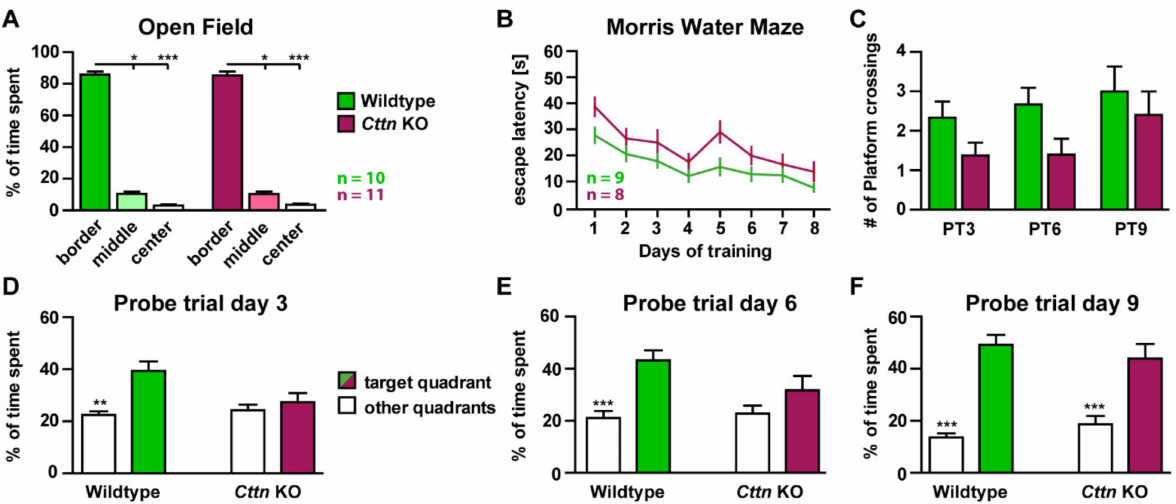
Figure 1. Behavioral analysis of Cortactin-deficient mice. ( A ) Wildtype and Cttn-deficient mice trained in the Open Field test [28]. Depicted is the percentage of time spent in the center, middle and border region of the test arena. n = number of animals. ( B ) Escape latency of male WT and Cttn-deficient animals trained for 8 days in the hidden platform version of the Morris Water Maze [29]. n = number of animals. ( C ) Amount of platform crossings in reference memory tests (‘Probe trials’, PT) performed on training day 3, 6 and 9. ( D – F ) Percentage of time spent in the target quadrant (the quadrant where the hidden platform was originally located) and the other quadrants in the reference memory test on ( D ) training day 3, ( E ) day 6 and ( F ) day 9. Data information: Statistic tests used: For normal distribution of data: Kolmogorov–Smirnov Test, Parametric Tests: Two-Way ANOVA and Sidak’s Multiple Comparisons, Non-Parametric Tests: Kruskal-Wallis Test and Dunn’s test; data depicted as means ± SEM, detailed information on p values as well as statistical tests is depicted in Table S1; significances are indicated by * p value < 0.05, ** p value < 0.01 and *** p value <